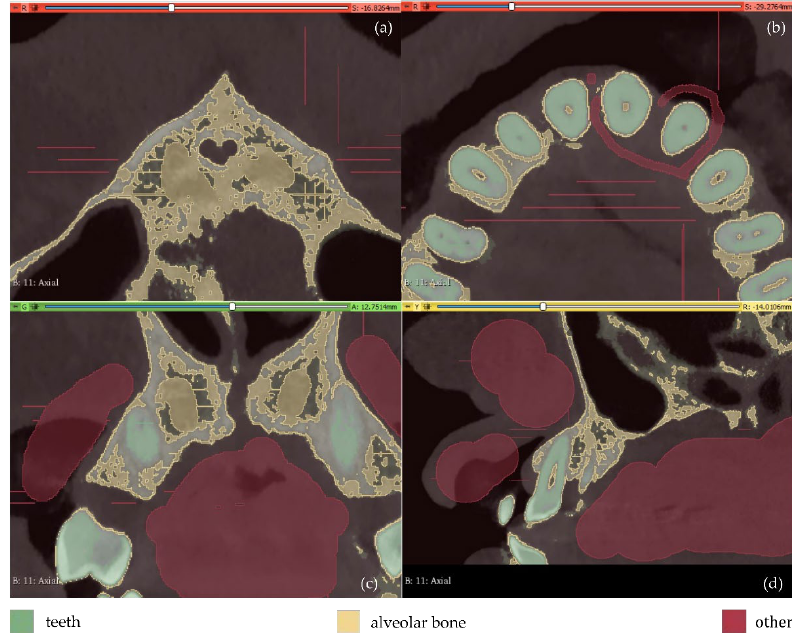
Figure 13. Manual definition of segments in CBCT slices (Experiment 4); ( a , b ): axial plane; ( c ): coronal plane; ( d ) sagittal plane.